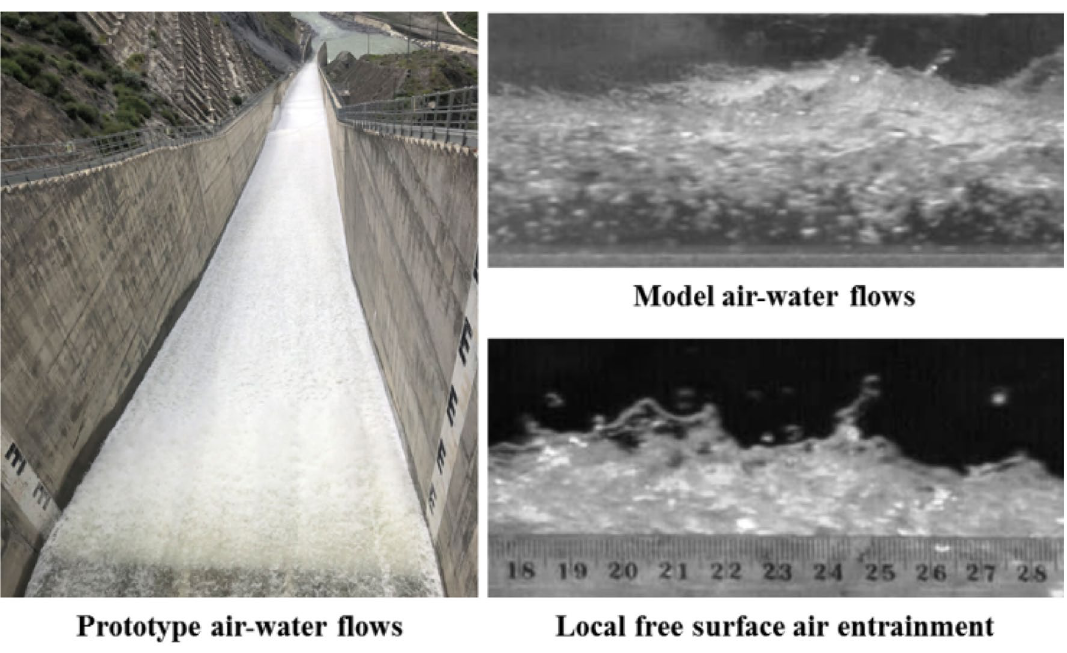
Figure 1. Typical air–water patterns of self-aerated flows in prototype spillways and laboratory